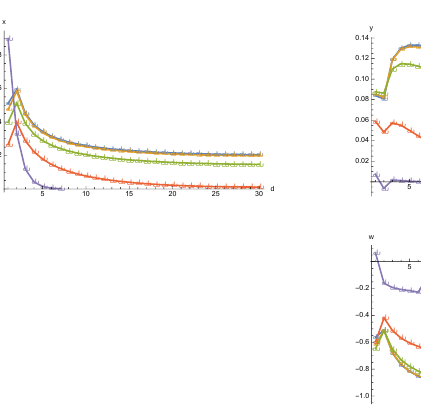
Figure 9 . The plots of the optimized value of the parameter x; y; z; w which gives the minimum of S in the setup of j A j = 1 ; j B j = 2. In the (cid:12)rst three graphs, from the above to the A ~ A